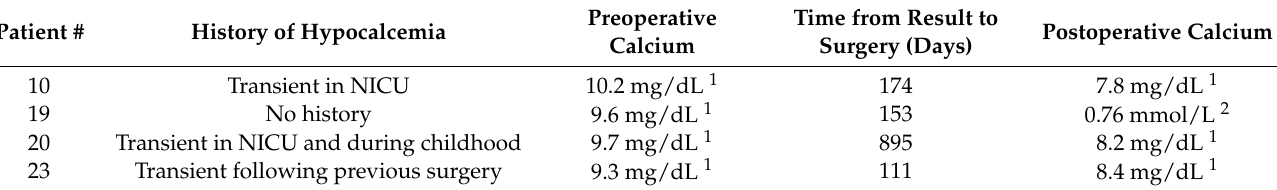
Table 2. Patients with postoperative